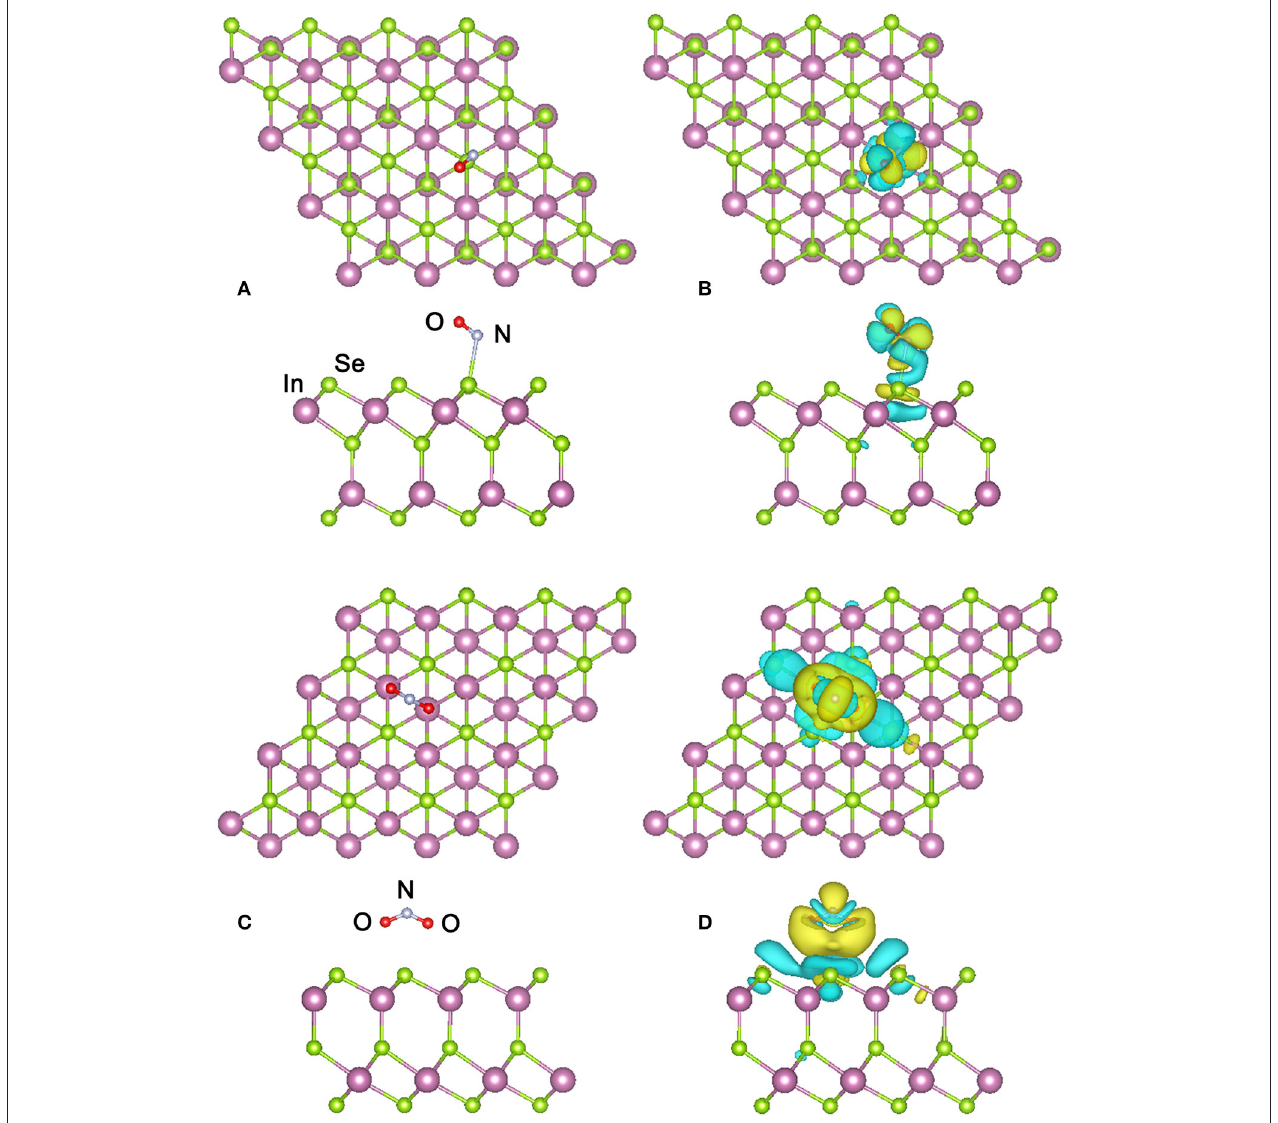
FIGURE 2 | (A) Top and side views of the most stable configuration of the α -In 2 Se 3 monolayer adsorbed by NO and (B) its charge density difference. (C) Top and side views of the most stable configuration of the α -In 2 Se 3 monolayer adsorbed by NO 2 and (D) its charge density difference. The cyan and yellow isosurfaces denote the electron depletion and accumulation, respectively. The isosurface value is set as 0.0001 e/bohr 3